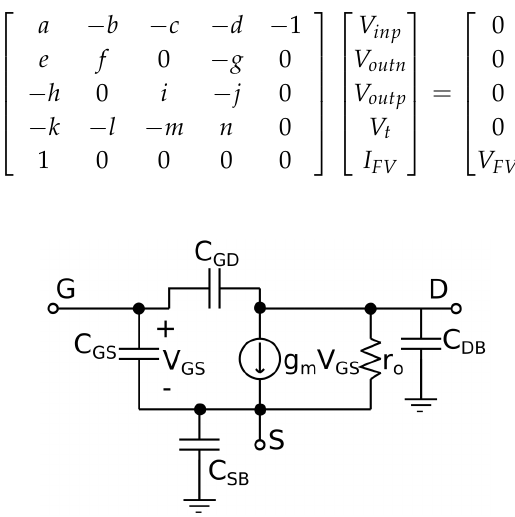
Figure 2. High-frequency MOSFET model [22].